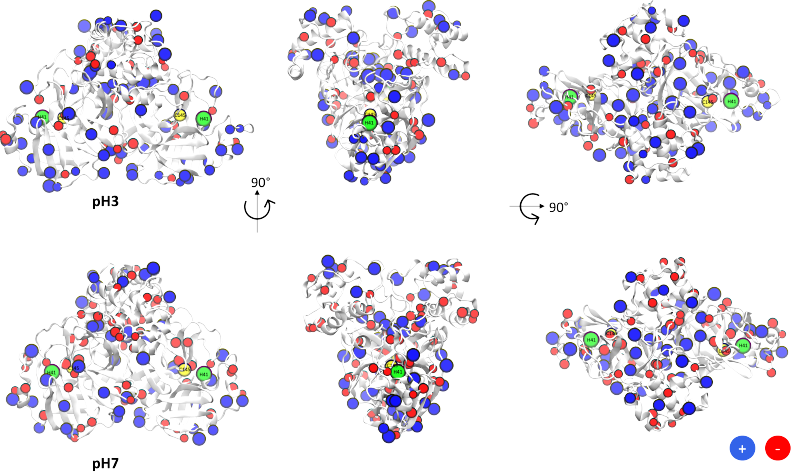
Figure 2. SARS-CoV-2 Main Protease (Mpro) with titratable group in beads representation. Yel- low beads (Cys145), green beads (His41), blue beads (basic amino acids) and red beads (acidic amino